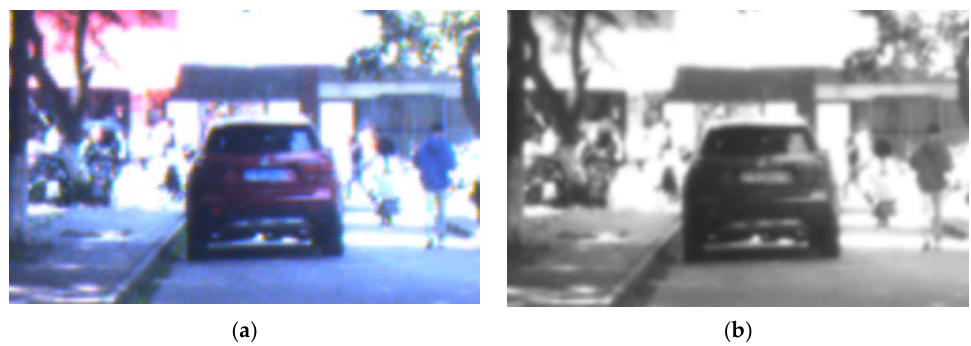
Figure 9. Image preprocessing. ( a ) Original image. ( b ) Grayscale image after smoothing.